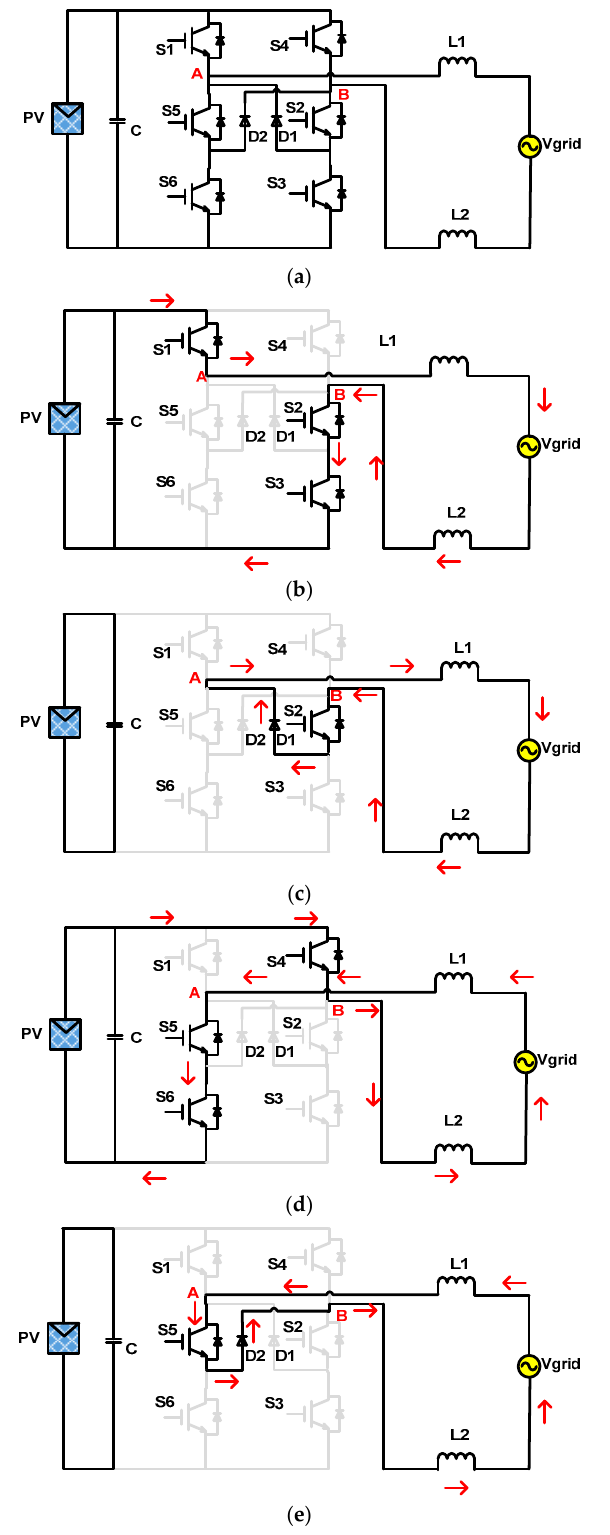
Figure 7. H6 I inverter and its operating modes. ( a ) H6 I inverter circuit, ( b ) current conduction during the positive half cycle of the grid voltage, ( c ) freewheeling mode during the positive half cycle of the grid voltage, ( d ) current conduction during the negative half cycle of the grid voltage and ( e ) freewheeling mode during the negative half cycle of the grid voltage.